Question: State the chart type depicted above.
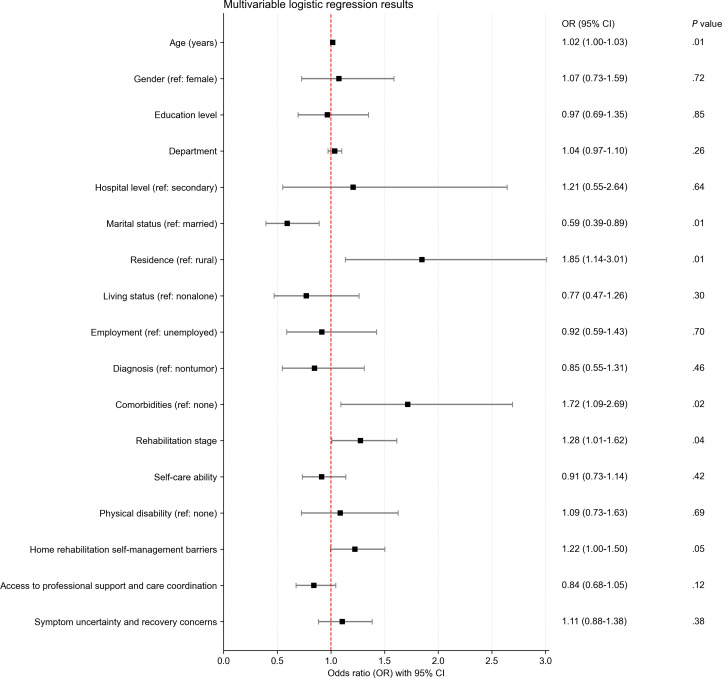
Answer: forest